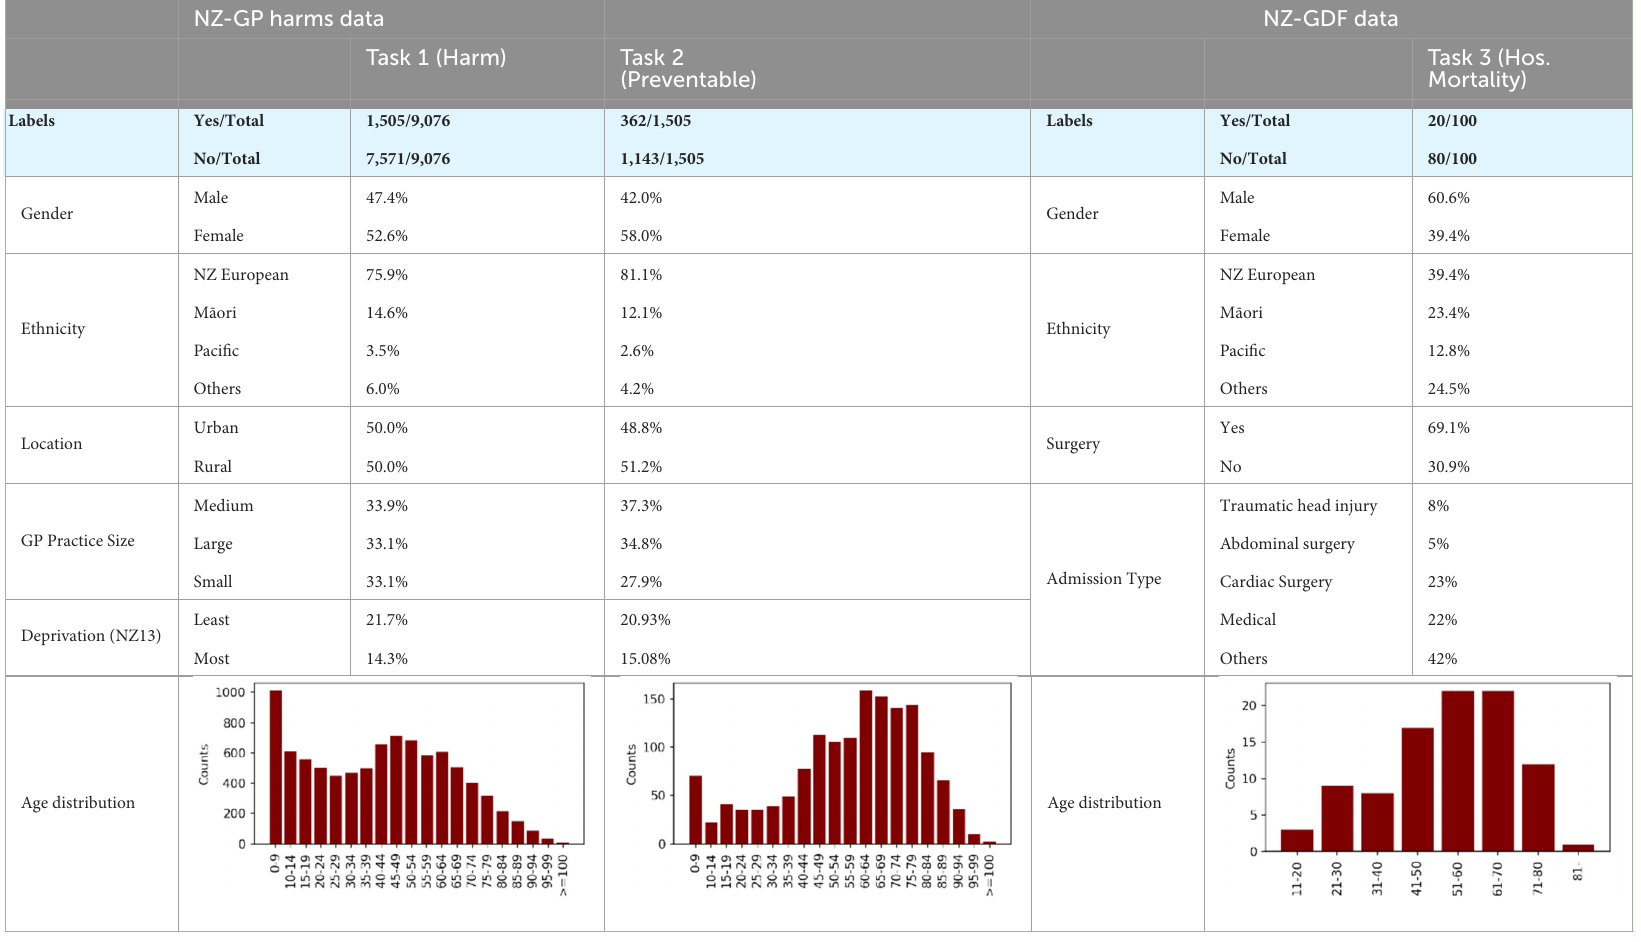
TABLE 1 Summary of NZ-GP Harms Data for Task 1 predicting patient harm; Task 2 predicting preventable harm among patients where harm is identified; and Summary of NZ-GDF Data for Task 3 predicting hospital mortality. NZ-GP harms data NZ-GDF data Task 1 (Harm) Task 2 (Preventable)